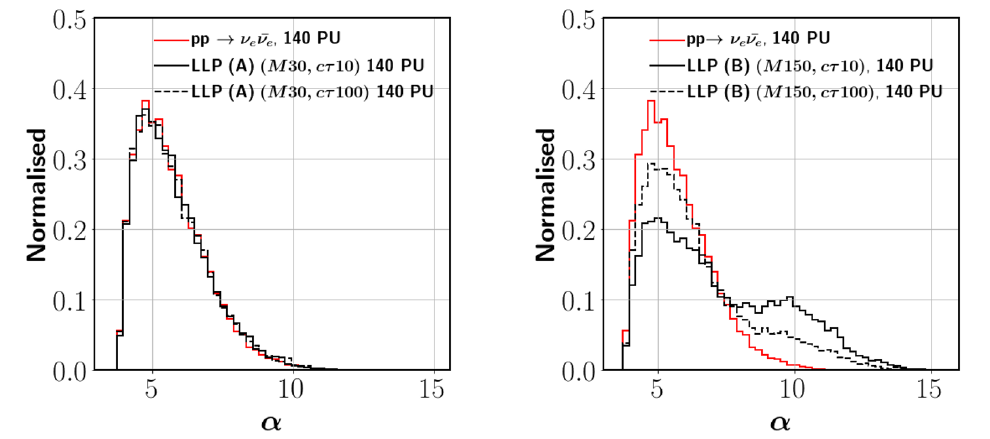
Figure 2 . Local shape variable, α , for LLPs from scenario (A) produced from the decay of 125 GeV Higgs boson with a mass of 30 GeV ( left ) and for pair produced LLPs from scenario (B) with a mass of 150 GeV ( right ) — both with decay lengths of 10 cm and 100 cm, all merged with an average of 140 PU vertices. Distribution coming solely from the merged 140 PU vertices is also shown for